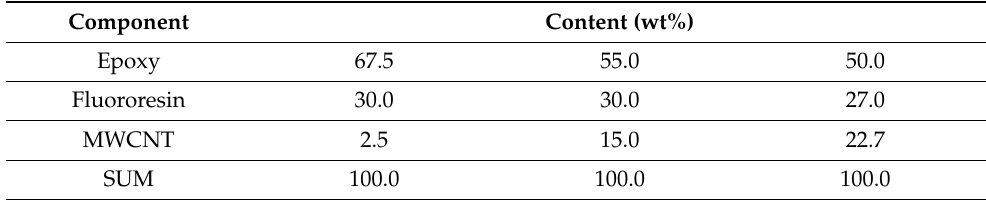
Table 2. Composition of epoxy and MWCNT components in solid lubricant for